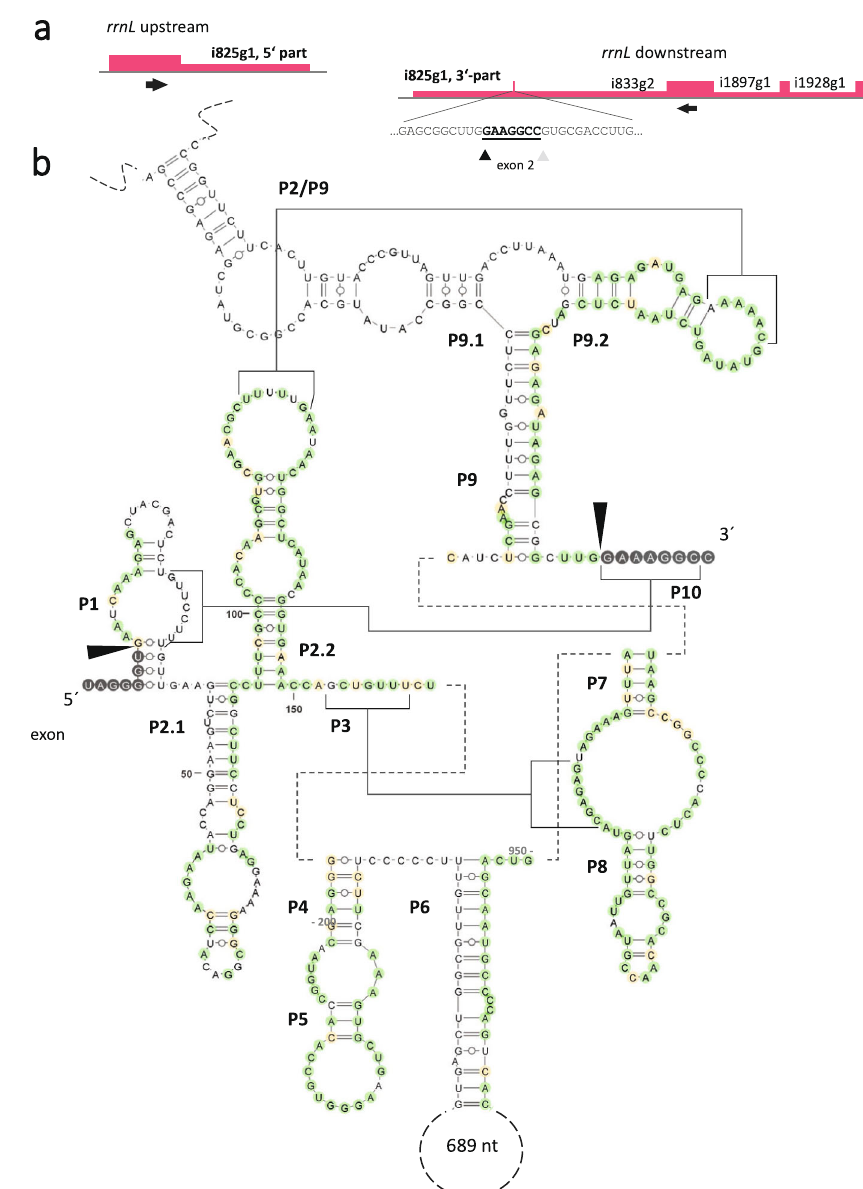
Fig. 5 A trans-splicing group I intron in the Haplopteris ensiformis mitochondrial rrnL gene. a Maturation of rrnL includes trans -splicing of the disrupted group I intron rrnLi825g1. Three additional introns are removed from the downstream part of rrnL . Group II intron rrnLi833g2 has a homolog conserved in the mtDNAs of liverworts and the downstream group I introns rrnLi1897g1 and rrnLi1928g1 are conserved in other Polypodiales species. Splice sites of rrnLi825g1 and rrnLii833g2 (black and gray triangles, respectively) frame the tiny second rrnL exon of only eight nucleotides. b Secondary structure model of the disrupted, trans -splicing group I intron rrnLi825g1. The fi gure was generated using the VARNA software 91 . Regions for base-pairing between the upstream and downstream parts of rrnLi825g1 are found in the group I intron secondary structure P9.1. Intron rrnLi825g1 intron has a positional ortholog in the sweet-water alga Chara vulgaris . Green and yellow shading indicates identical nucleotides and transitions,